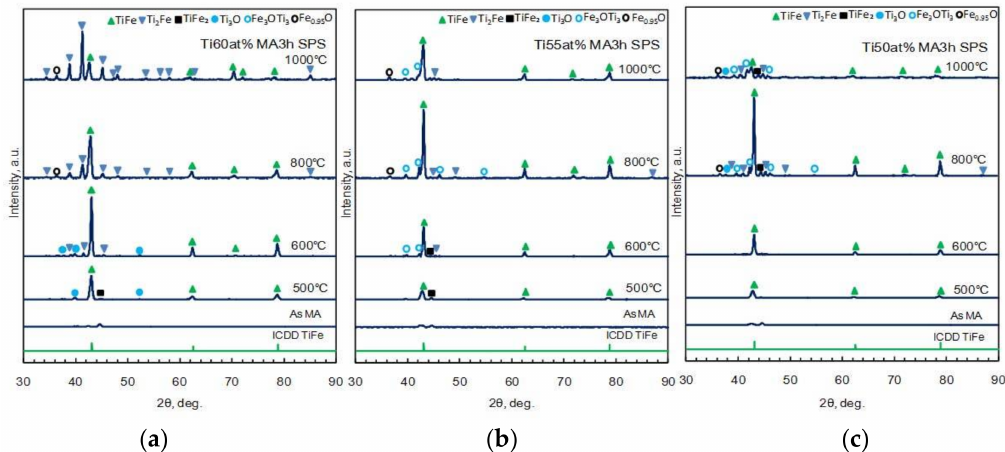
Figure 6. XRD patterns of 3 h MA samples undergoing different SPS treatments. ( a ) 60 at % Ti-Fe; ( b ) 55 at % Ti-Fe; ( c ) 50 at % Ti-Fe.